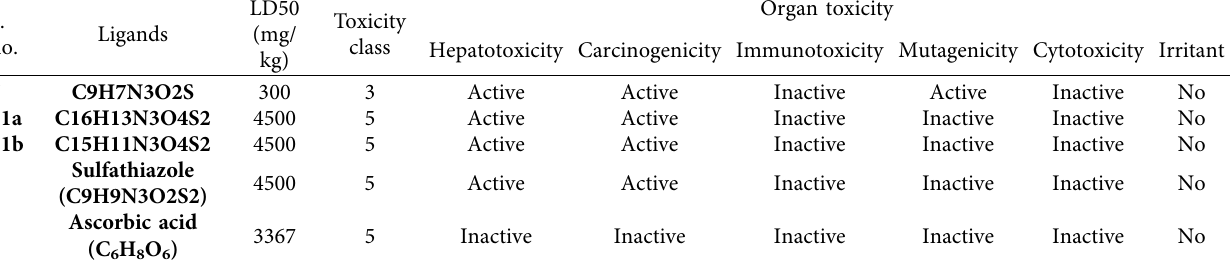
Table 7: Toxicity prediction of compounds, computed by ProTox-II and OSIRIS property explorer. S.